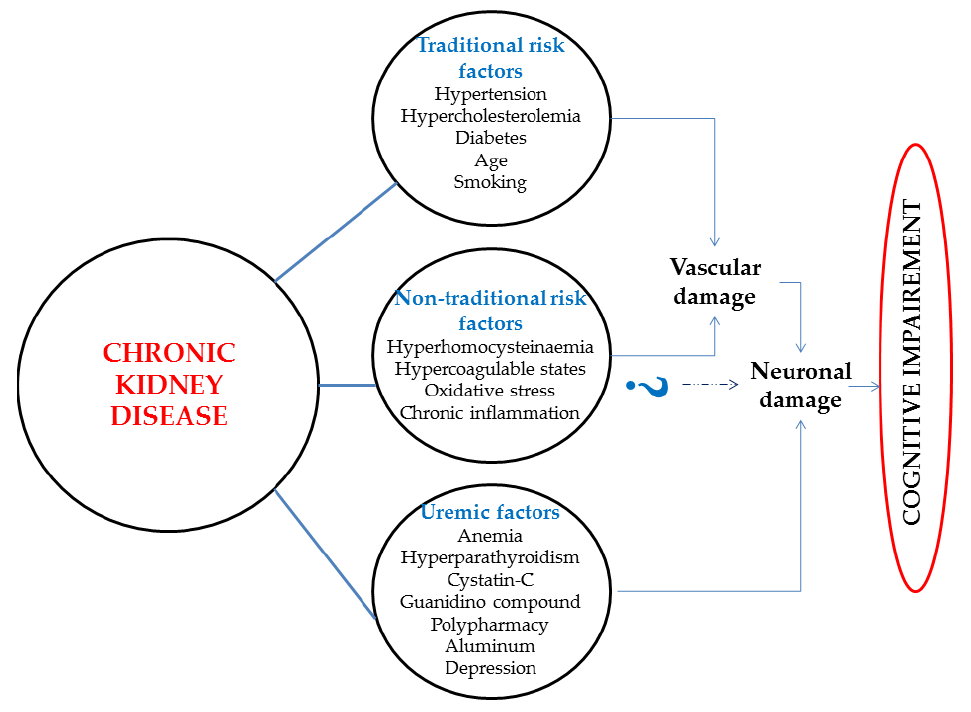
Figure 1. Factors linking chronic kidney disease and Alzheimer’s disease.